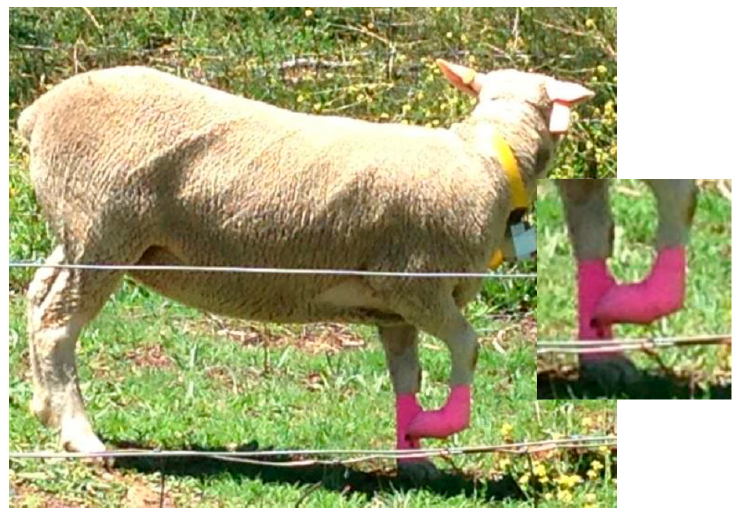
Figure 3. Experimental animal showing the method used to simulate lameness behaviour (main photo and inset). The method of restraint prevented any weight bearing on the restrained